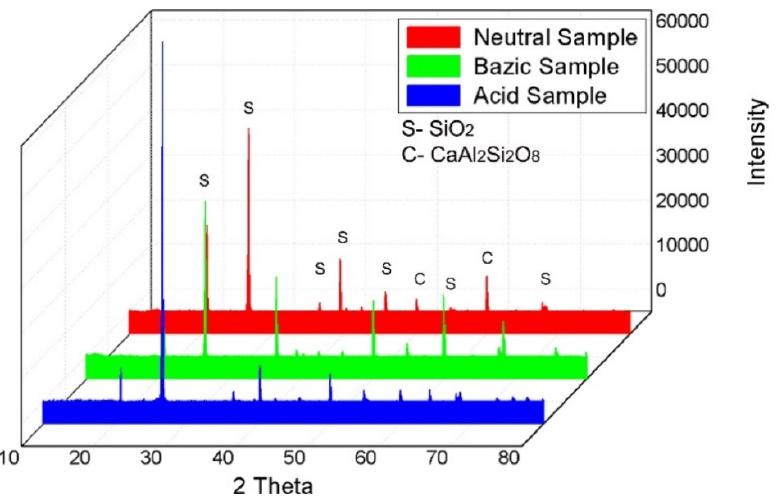
Figure 7. XRD analysis of 3 experimental samples .